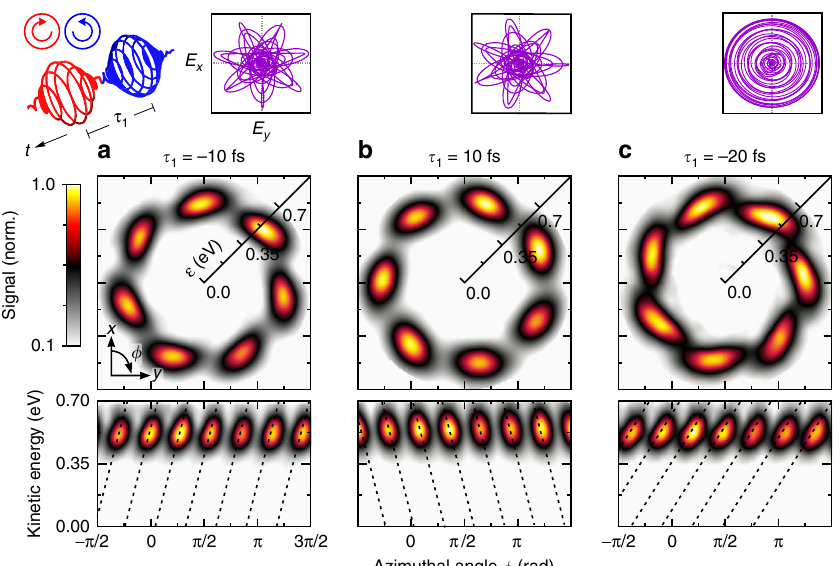
Fig. 5 Spiral-shaped FEWPs with sevenfold rotational symmetry from time-delayed (3 ω :4 ω ) CRCP pulses. Energy-calibrated central x - y sections through the reconstructed PMDs for different time delays τ 1 between an LCP red and an RCP blue pulse. a The negative time delay of τ 1 = − 10 fs (red pulse precedes the blue) produces a 7-armed spiral with clockwise sense of rotation in the laser polarization plane. b Reversal of the pulse ordering by changing the sign of τ 1 inverts the rotational sense. c By separating the pulses in time ( τ 1 = − 20 fs) the CRCP sequence becomes circularly symmetric. However, the FEWP retains its sevenfold rotational symmetry. The time delays were extracted from the slope of the tilted lobes using PCA. The given uncertainties are statistical errors from the average over the results obtained for each of the seven